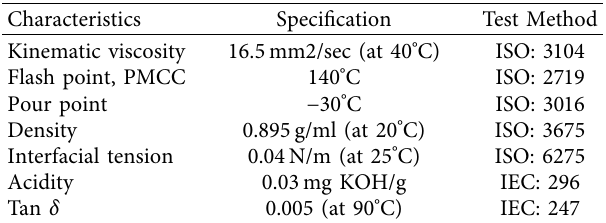
Table 1: Specification of mineral oil used for impregnated pressboard.